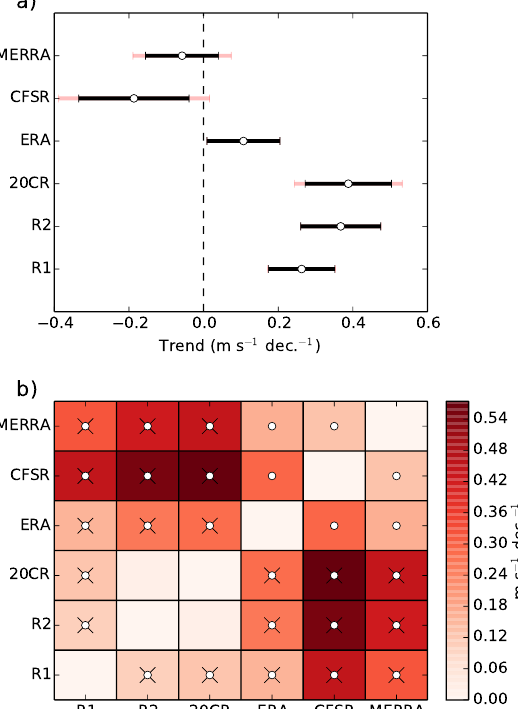
Figure 8. (a) Trends in the 10m wind speed at the peak of the SH westerly jet over 1980 to 2010 in the six runs forced by reanalysis winds with 95% confidence intervals in black and adjusted 95% confidence intervals in red; (b) trends of the difference time series in wind speed between all pairwise combinations of the reanalyses are given by the shading. A black “x” indicates that the trends are significantly different at the 5% level, based on an adjusted p value and a white circle indicates that the trends are significantly different at the 5% level, based on an unadjusted p value.